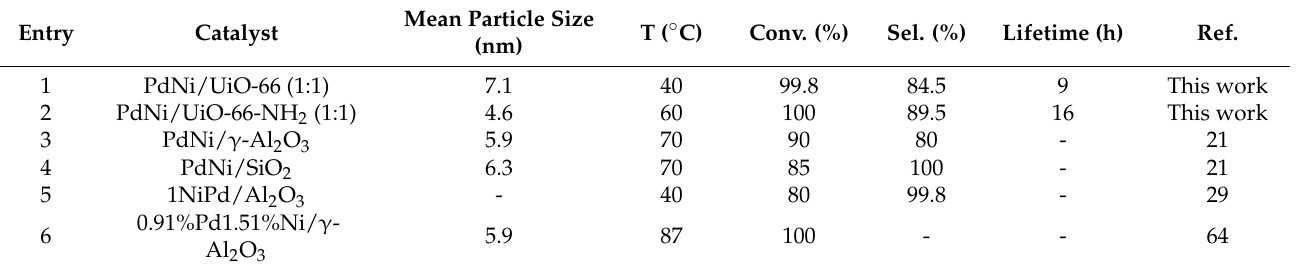
Table 2. The BD conversion and butene selectivity toward total butenes over supported Pd-Ni bimetallic catalysts for the BD hydrogenation